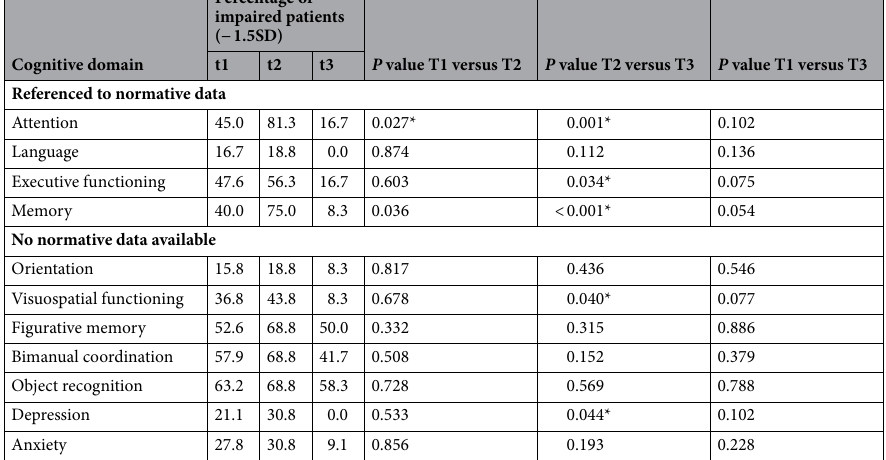
Table 4. Patients’ neurocognitive function in the different domains over time. * P value < .05, defining significant deviation.